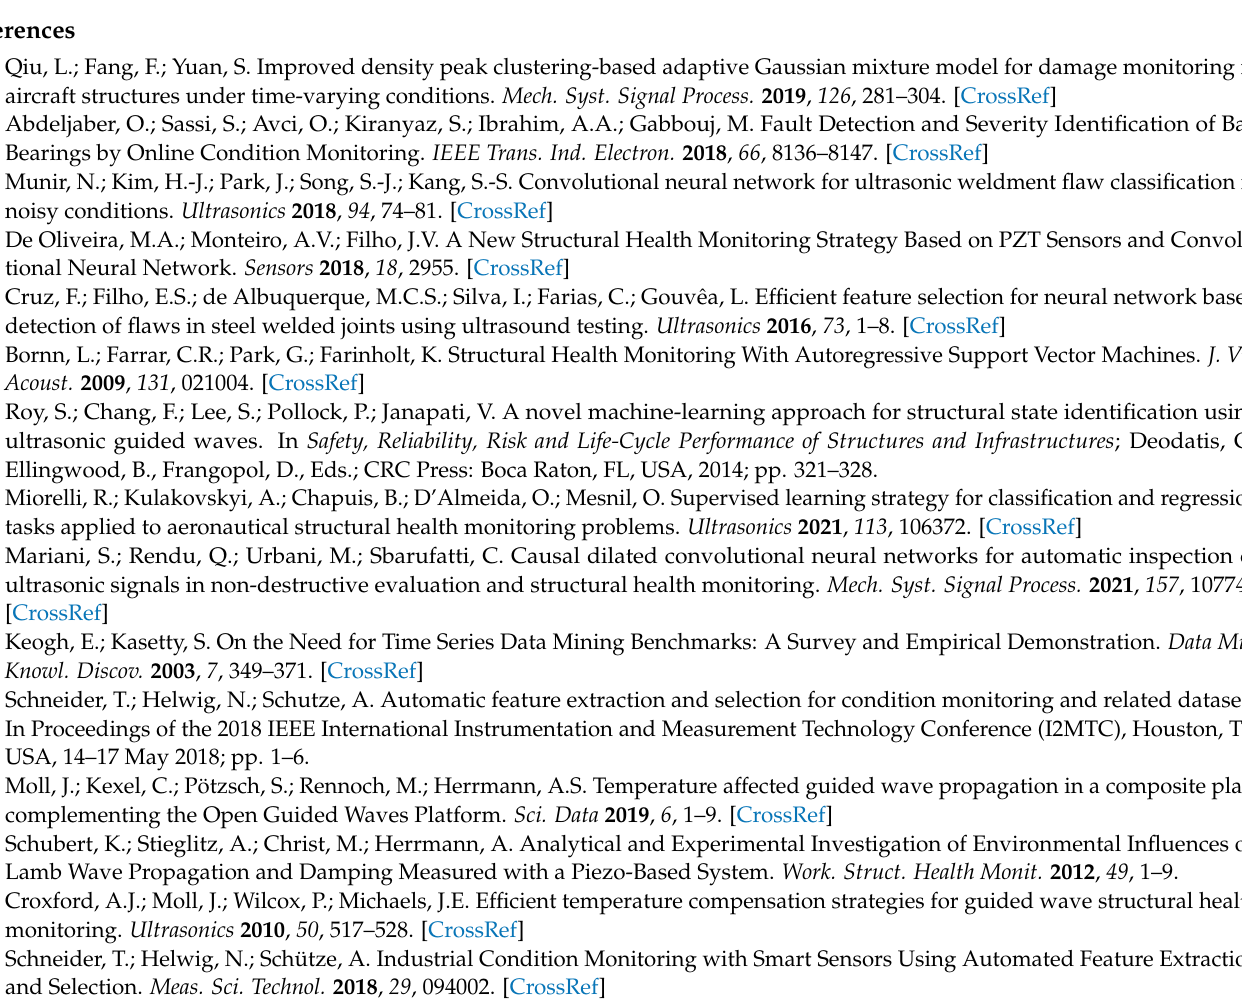
Figure A2. Resulting accuracy of the validation data for various parameter combinations (parameter C of the SVM and number of features selected by RELIEFF). Parameter combinations within the purple boxes achieve 100% validation accuracy. The gap between the two purple boxes consists of parameter combinations achieving an accuracy of